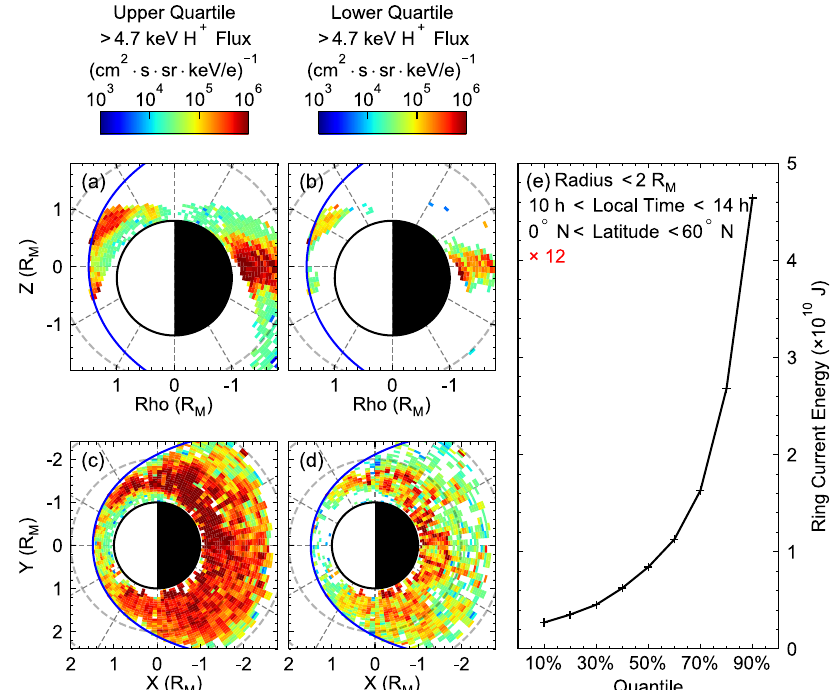
ffiffiffiffiffiffiffiffiffiffiffiffiffiffiffiffiffiffiffiffiffi q 1 þ Y 2 = X 2 ). c , d Distribution of the upper and lower quartiles of the energetic proton fl ux